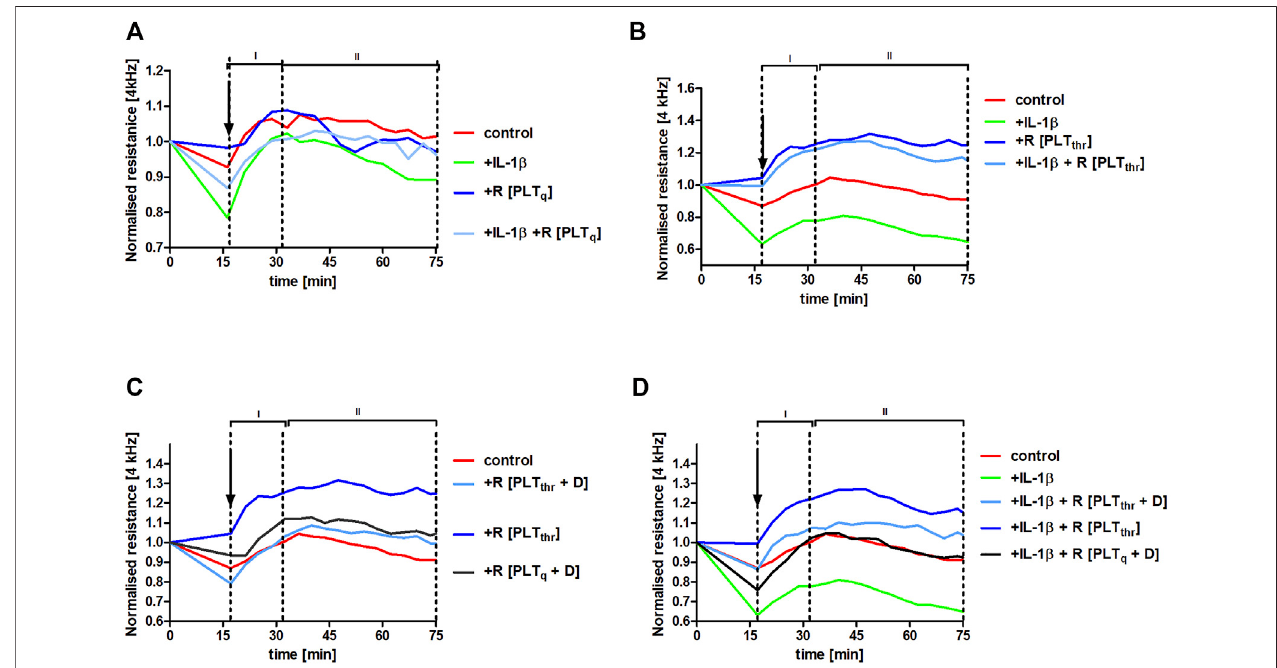
FIGURE 6 | Protection of human pulmonary endothelial barrier compromised by IL-1 β stimulation afforded by releasates of washed human platelets and the reversal of this effect by dabigatran. Human lung microvascular endothelial cell (HLMVEC) monolayers were treated with releasates derived from non-stimulated PLT (R [PLT q ]) (A) orPLT stimulated with.1 U ml − 1 thrombin (R [PLT thr ]) (B) in thepresence of10 ng ml − 1 IL-1 β orwithoutIL-1 β .The effect ofreleasatesderivedfrom thrombin- stimulated PLT on the barrier integrity formed by HLMVECs in the presence of 30 ng ml − 1 of dabigatran (R [PLT thr + D]) was also tested without IL-1 β (C) or in the presence of IL-1 β (D) . The data are shown as the mean of 3 – 4 independent experiments and were analysed using analysis of covariance (ANCOVA) in the stable phase (II). Thrombin alone added in Tyrode buffer (.1 U ml − 1 ; the fi nal concentration of .01 U ml − 1 ) did not affect endothelial barrier